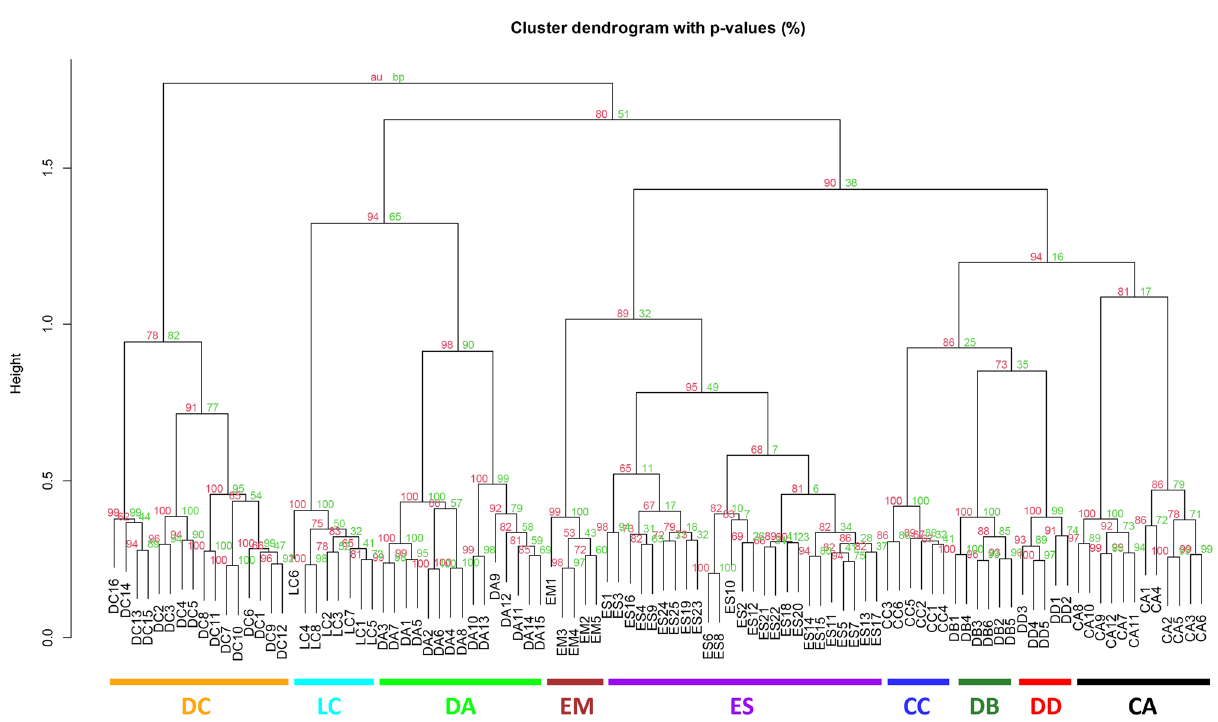
Figure 4. Cluster dendrogram with the p values (%) of nine Diphyids (98 spectra). The number of each node dictates the AU (Red) and BP